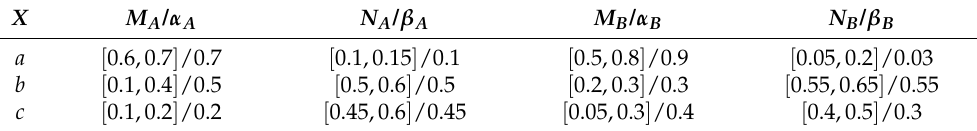
Table 3. CISs A and B